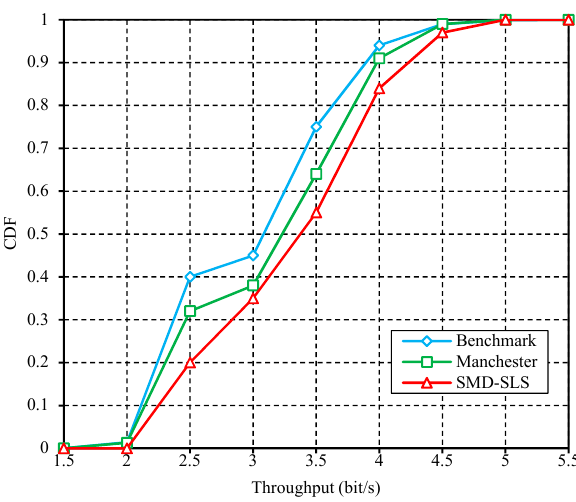
Figure 11. Average throughput vs CDF in a heterogeneous medium.